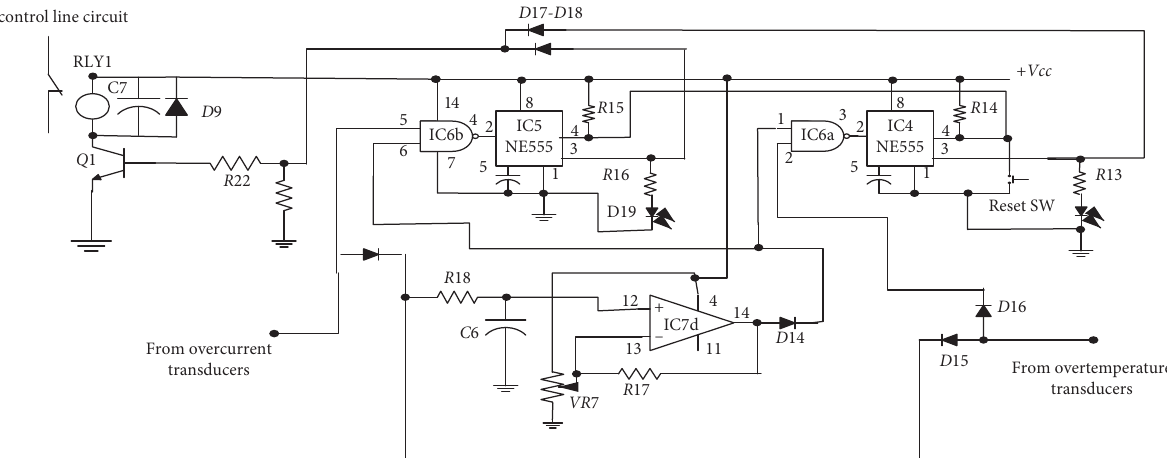
Figure 7: The circuit diagram of the delay, indicator, and auto shutdown units.